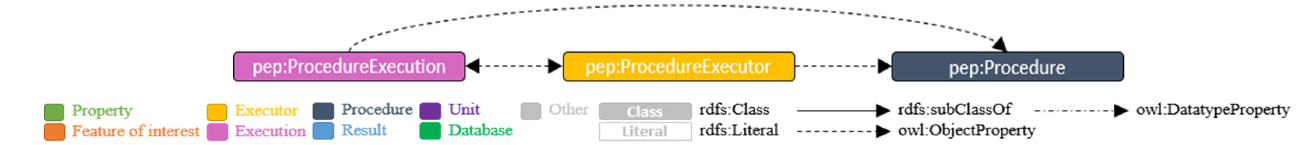
Figure 11. Procedure execution pattern of PEP, generalizing SEAS.